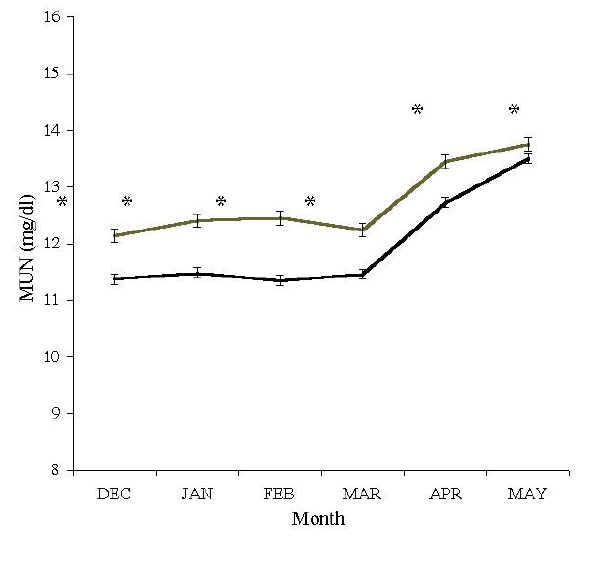
FIGURE 2. Monthly MUN (mg/dl) concentrations for dairy farms that participated in the program (top line) compared to those who choose not to participate (bottom line). *Contrasts by month differ by p <